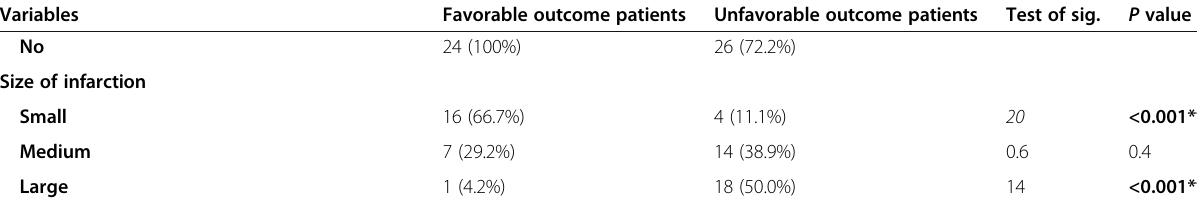
Table 1 Comparison between patients with favorable and unfavorable outcomes regarding inflammatory biomarkers, stroke severity, and short-term outcome (Continued) Variables